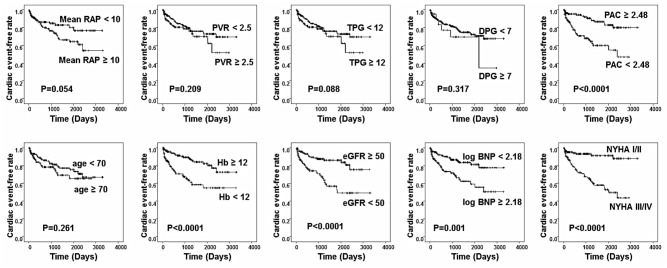
Kaplan-Meier curves for cardiac event-free rates in LHD-PH patients.The cardiac event-free rate significantly differed between PAC ≥ 2.48 and < 2.48 ml/mmHg, log BNP ≥ 2.18 and < 2.18, eGFR ≥ 50 and < 50 ml/min/1.73 cm2, Hemoglobin ≥ 12 and < 12 mg/ml, and NYHA classification III/IV and I/II. To the contrary, no difference was observed in the cardiac event-free rate between mean RAP ≥ 10 and < 10 mmHg, PVR ≥ 2.5 and < 2.5 WU, TPG ≥ 12 and < 12 mmHg, DPG ≥ 7 and < 7 mmHg, and age ≥ 70 and < 70 years.